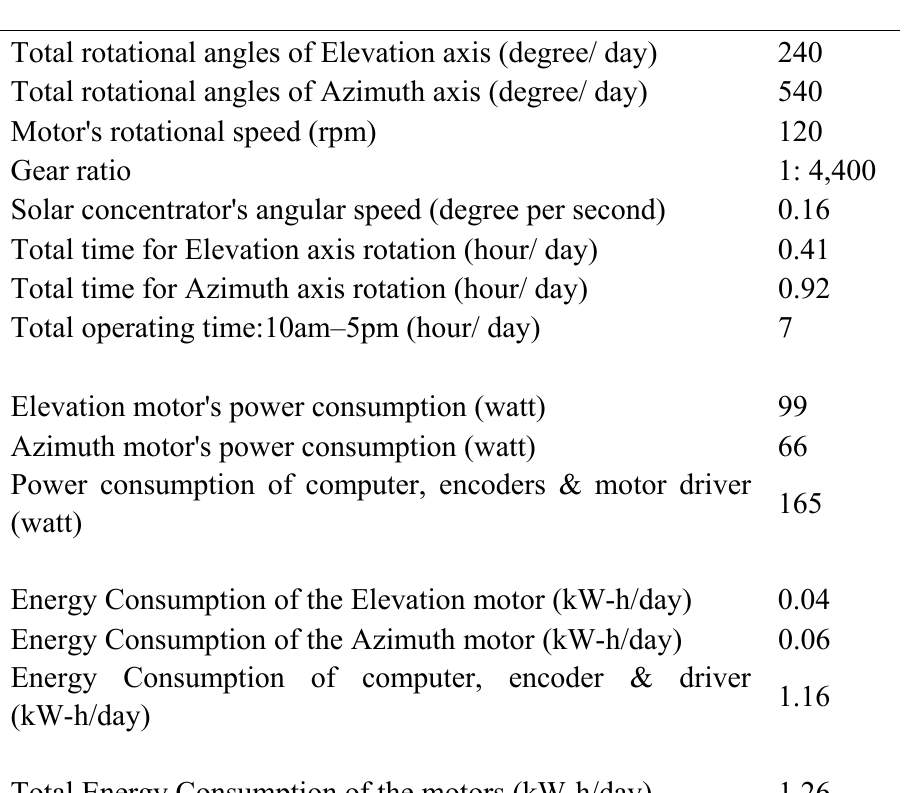
Table 1. Specification and energy consumption of prototype sun-tracking